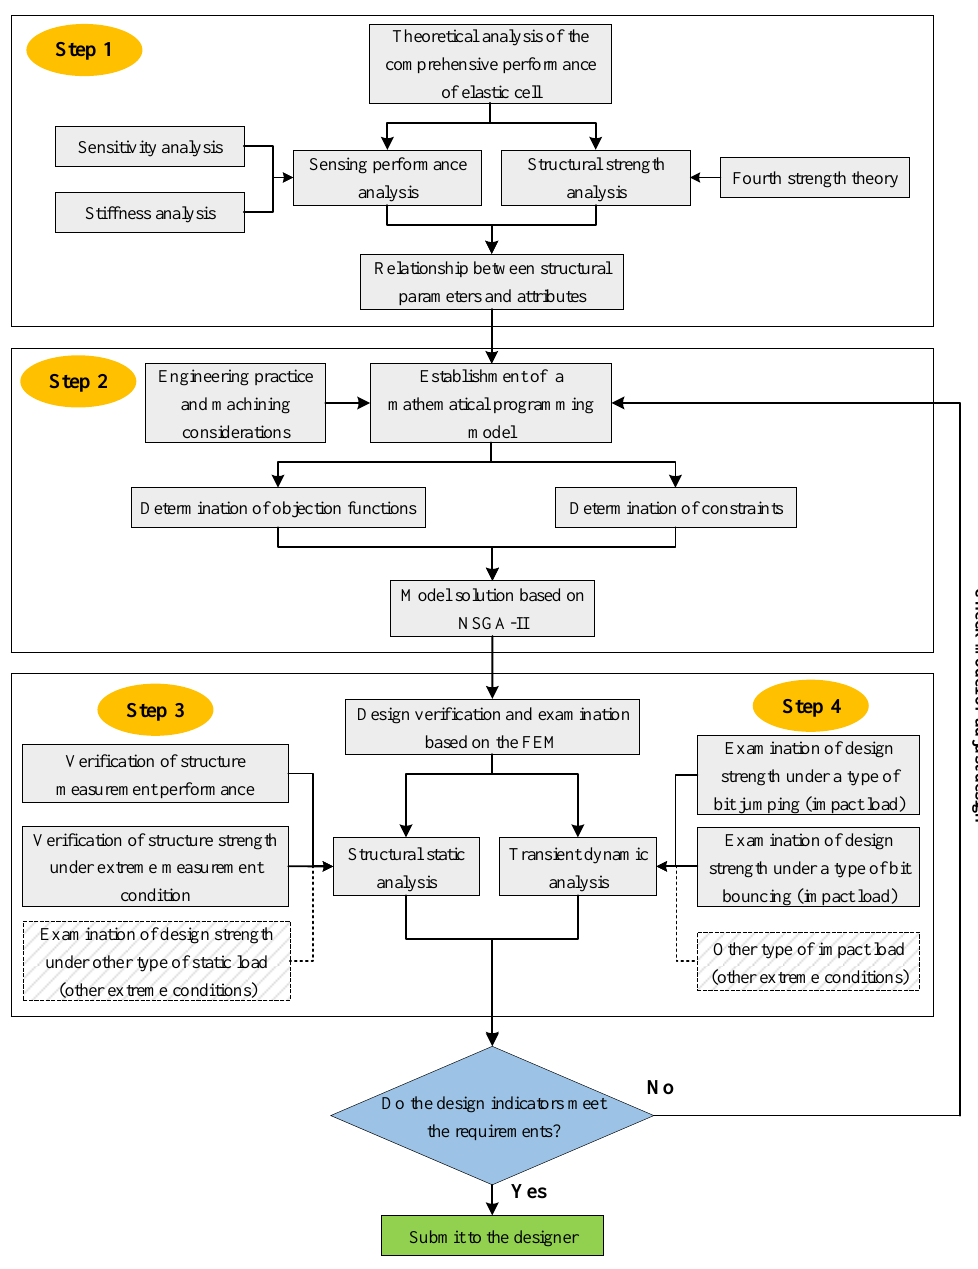
Figure 1. Proposed methodology framework for structural parameters optimization.